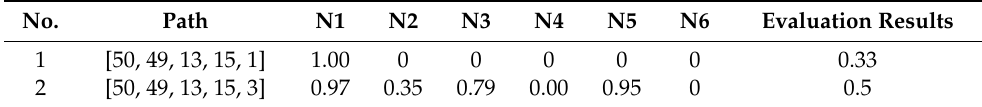
Table 2. Distribution network route and evaluation (20 kV).